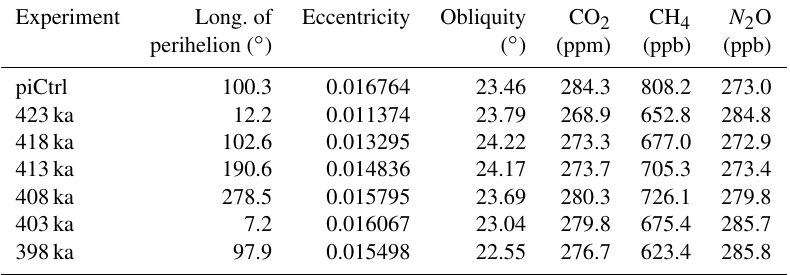
Table 1. Orbital parameters and GHG values used as fixed inputs into each